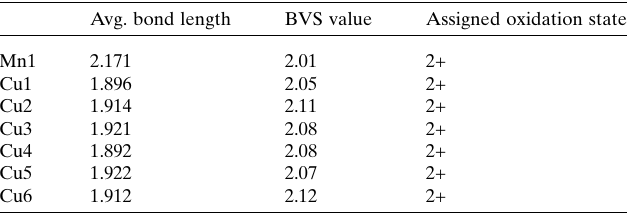
Table 1 Average bond-length (A˚ ) and bond-valence-sum (BVS; v.u.) values used to support the assigned oxidation states of the copper and manganese ions.